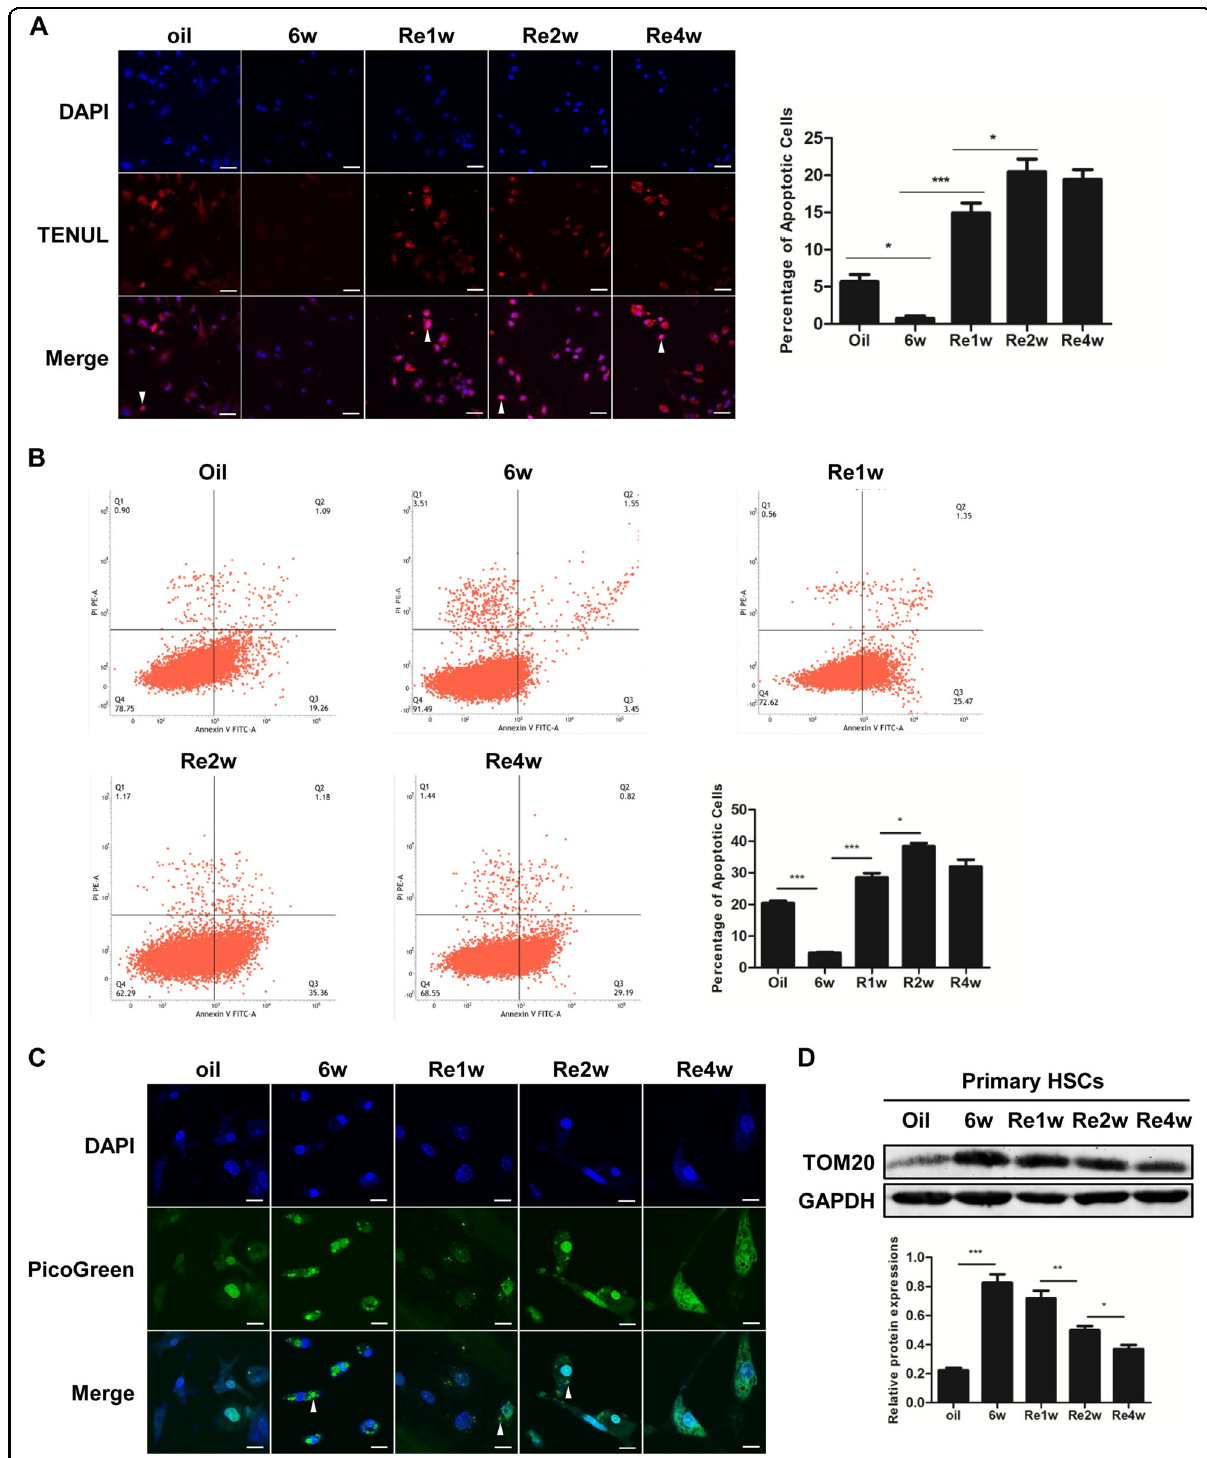
Fig. 1 Mitophagy is enhanced in parallel with increased apoptosis in primary hepatic stellate cells during the reversal of hepatic fi brosis. a TUNEL staining of primary HSCs derived from the indicated mice; scale bar, 25 μ m. Bar graph represents the mean ± SEM. * P < 0.05 and *** P < 0.001 vs. the indicated groups. b Annexin V-FITC/PI double-staining and fl ow cytometry analysis of primary HSCs; bar graph represents the mean ± SEM. * P < 0.05 and *** P < 0.001 vs. the indicated groups. c Mitochondrial DNA (mtDNA) measured by PicoGreen staining; scale bar, 10 μ m. d Representative western blots of the mitochondrial membrane protein TOM20 with GAPDH serving as the internal